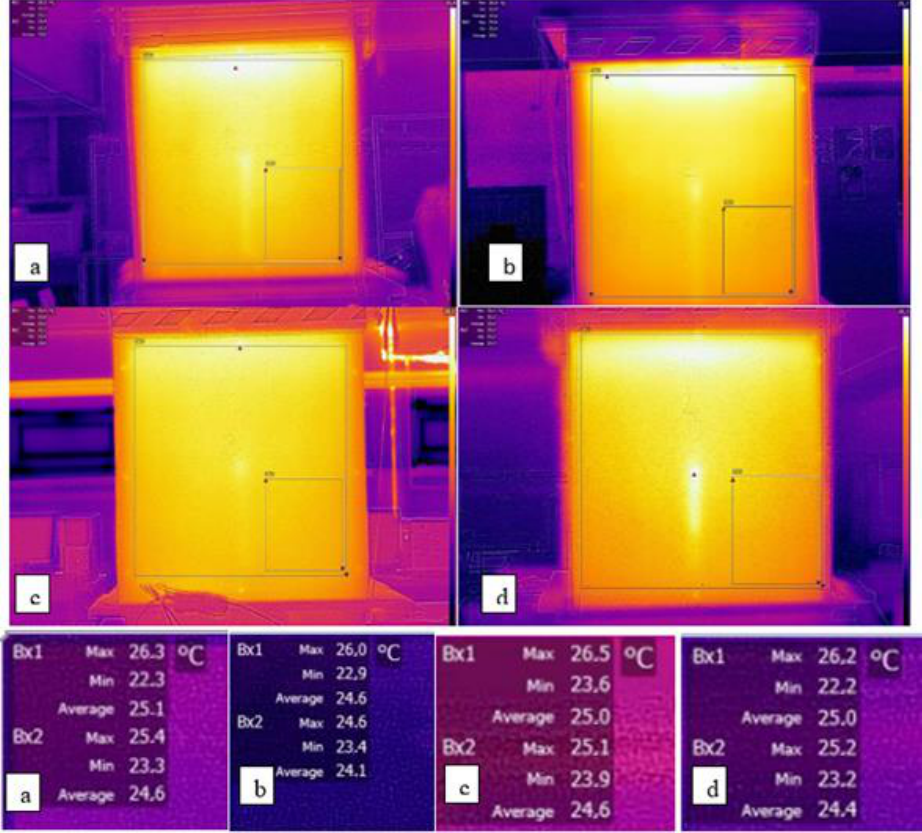
Figure 6. Measurement with a thermal camera of the temperature distribution on the outer walls of the measuring cube: ( a )—side wall 1; ( b )—side wall 2; ( c )—side wall 3; ( d )—side wall